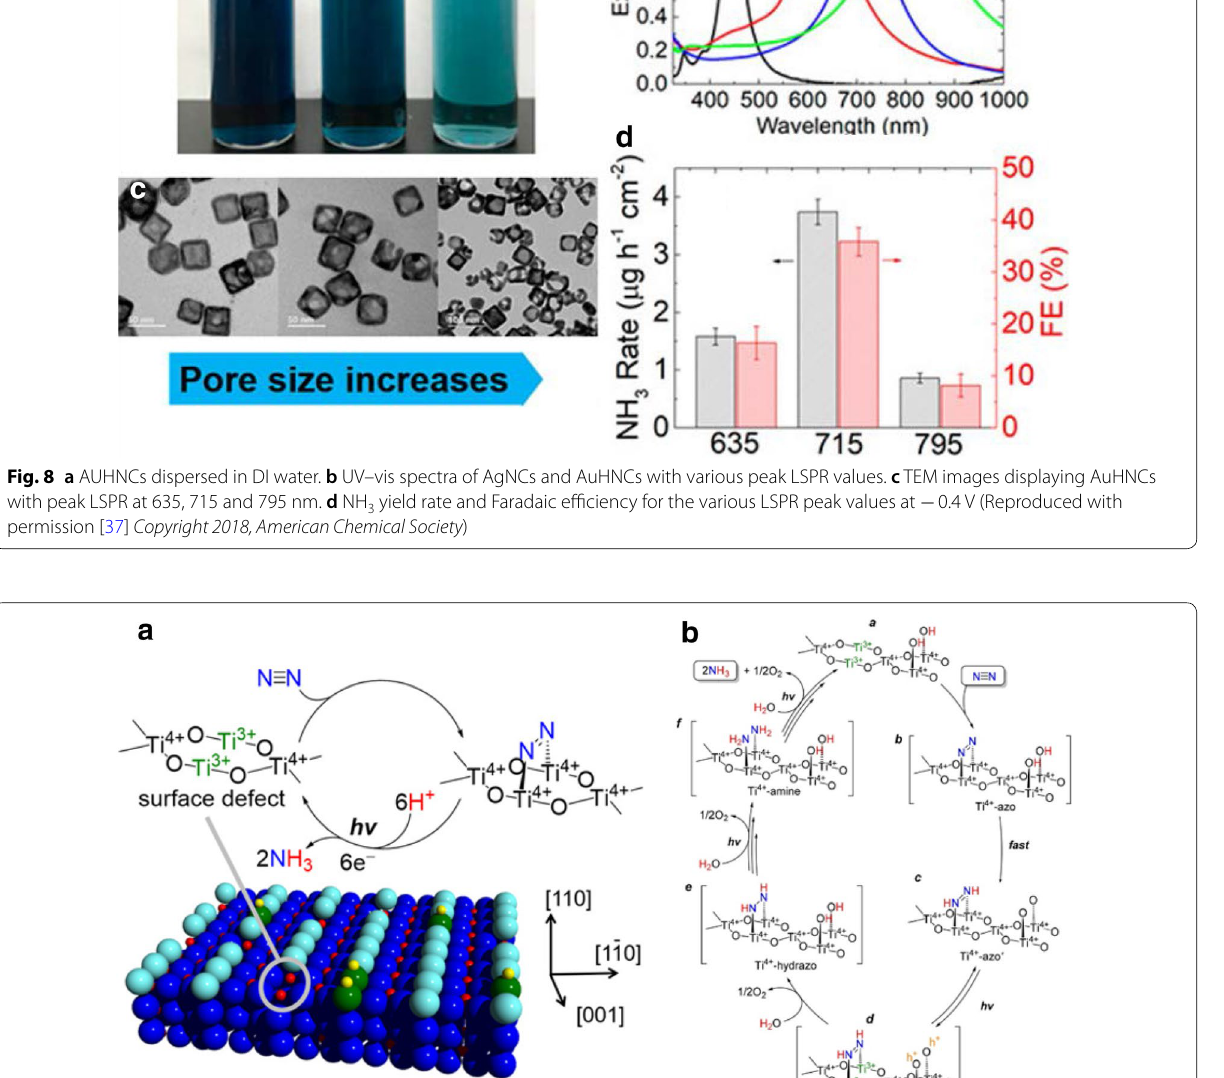
Fig. 9 a Photocatalytic N 2 fixation on the surface of Rutile TiO 2 (110) surface. b The mechanism for the photocatalytic fixation of N 2 to NH 3 over the surface oxygen vacancies of TiO 2 (Reproduced with permission [49] Copyright 2017, American Chemical Society